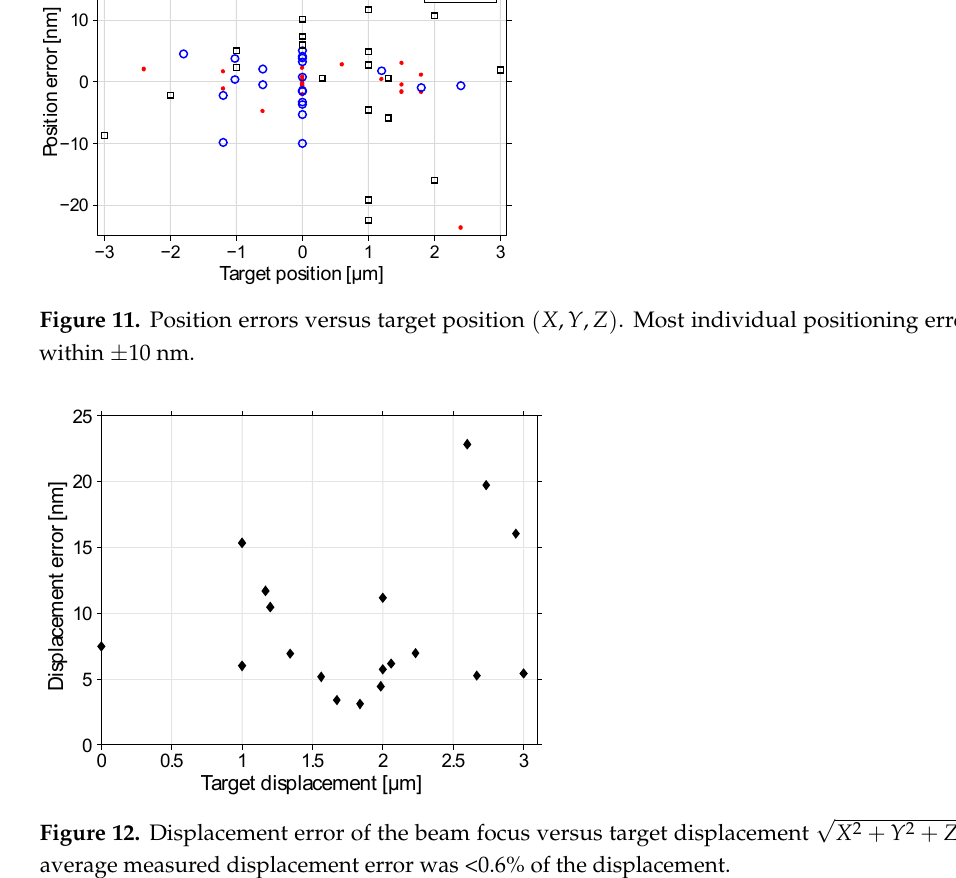
√ X 2 + Y 2 + Z 2 . The